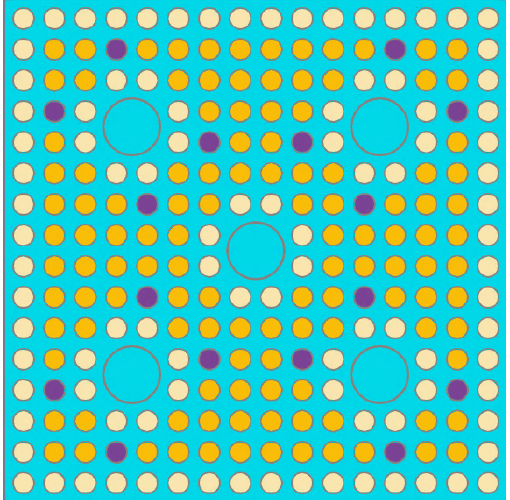
Figure 6. C3 Fuel Assembly Model Generated by MPACT.